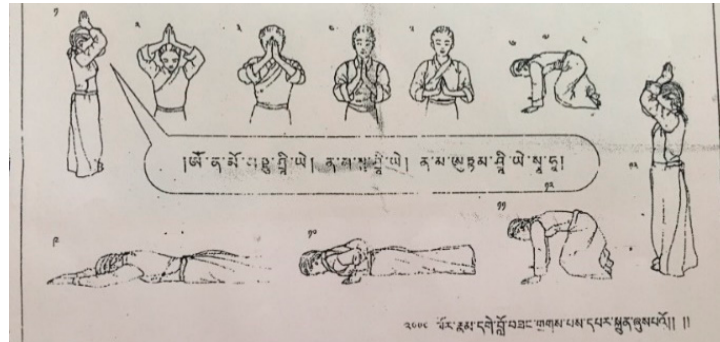
Figure 2. A handout given to prostrating practitioners at Bodhgaya’s Mahabodhi Temple grounds, produced in 2000 by Namgey Lobsang Trapa.